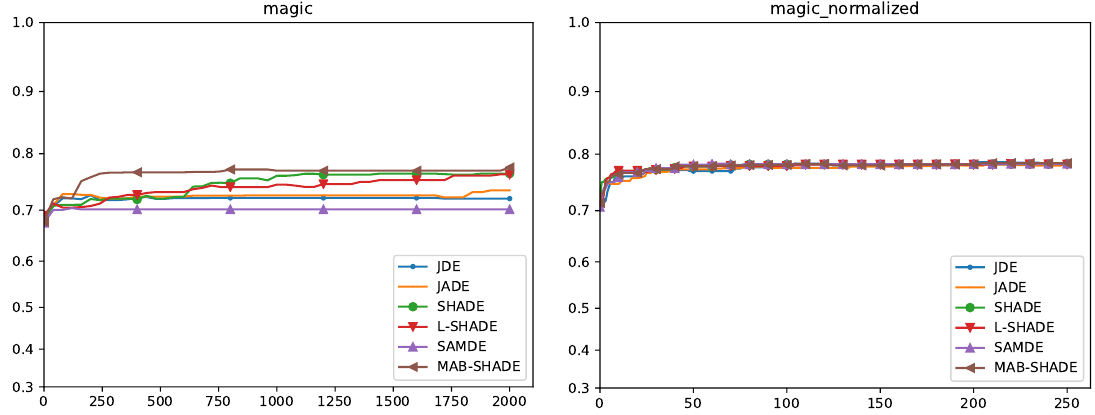
Figure 1. Plots of convergences on MAGIC and MAGIC normalized datasets.